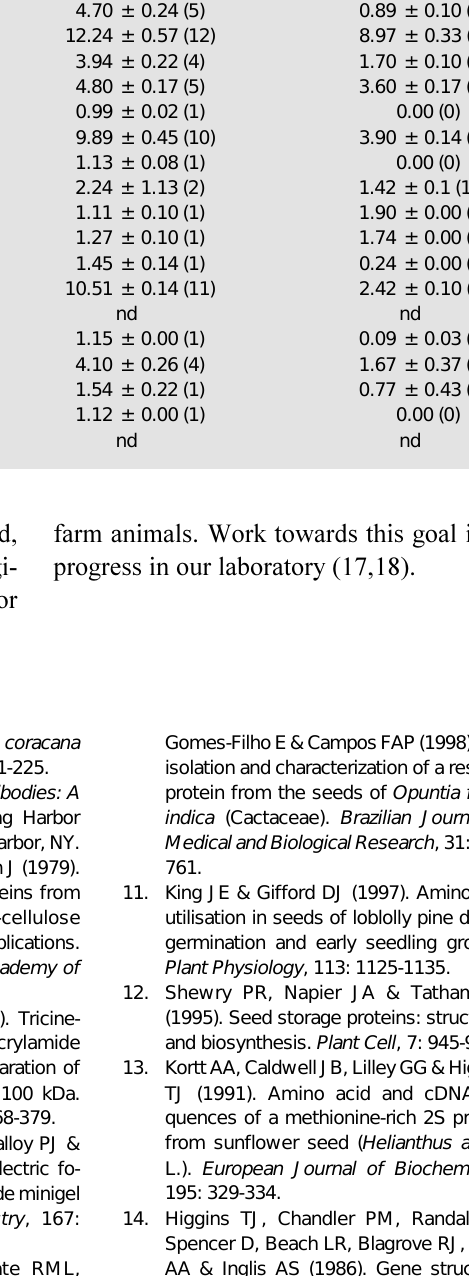
Table 1 - Amino acid composition of the methionine-rich protein isolated from the seeds of Cereus jamacaru , as determined by the Pico Tag method. Composition is reported as number of residues per mol of protein based on molecular masses of 11300, 7630 and 3670 kDa for the native, large and small chains, respectively. The values for cysteine and tryptophan were not determined (nd). Numbers within parentheses represent the assigned integral values. Amino acid Native Large